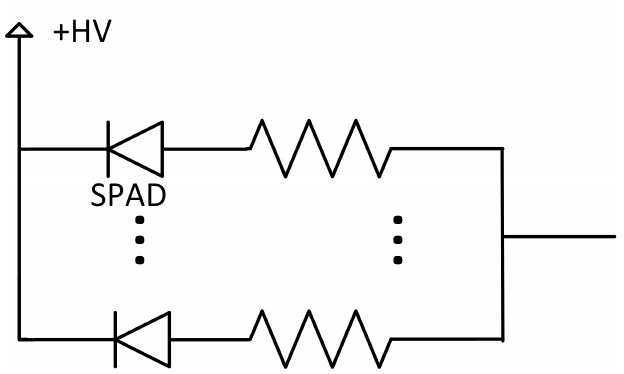
Figure 1. Schematic of an analog